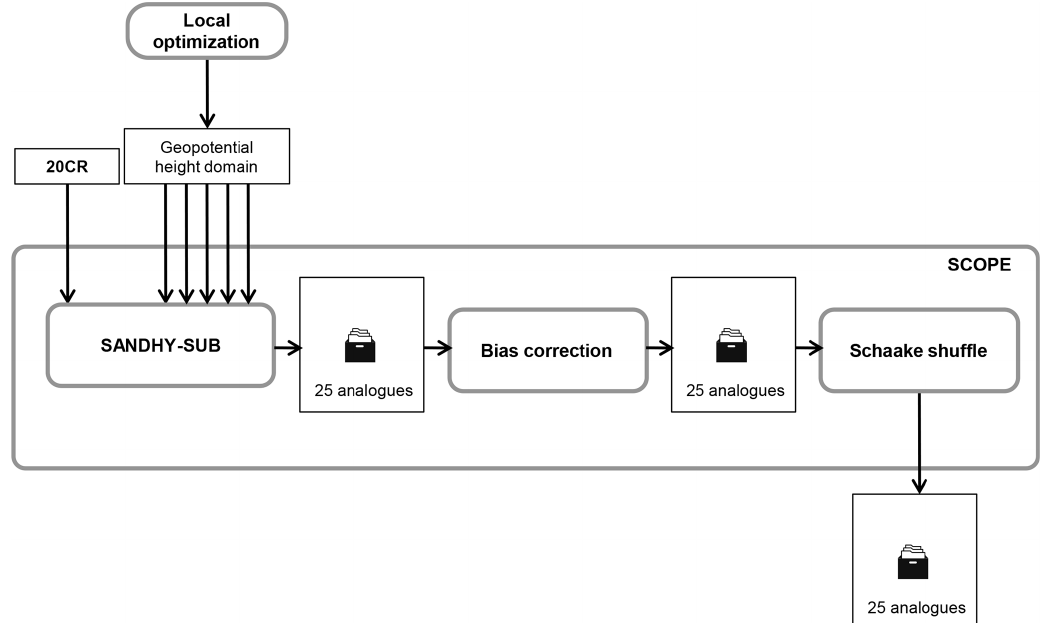
Figure 2. Synthetic diagram showing the sequence of steps for the SCOPE method and its use for SCOPE Climate reconstructions. Repro- duced from Caillouet et al.